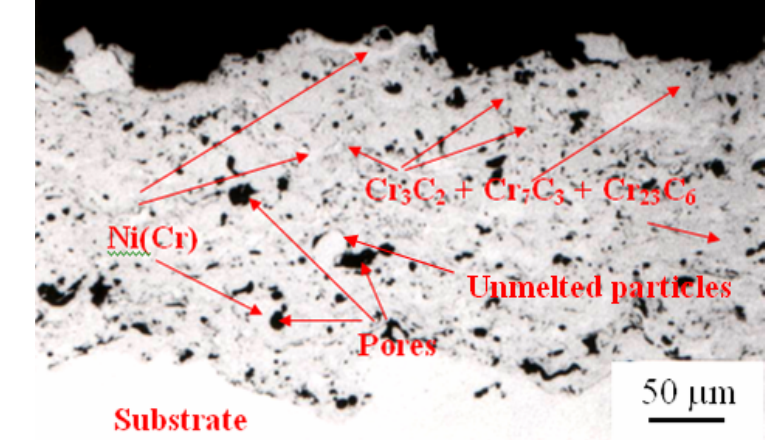
Figure 6 – 75Cr3C2 - 25Ni(Cr) coating microstructure deposited with the powder feed rate of 60 g/min Slika 6 – Mikrostruktura 75Cr3C2 - 25Ni(Cr) prevlake deponovane sa brzinom dovoda praha 60